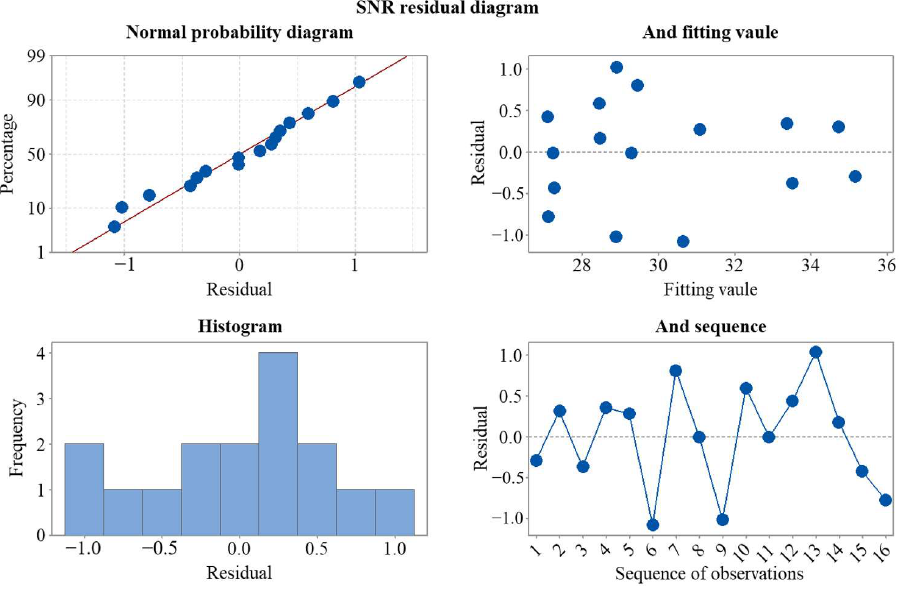
Figure 5. SNR residual diagram.